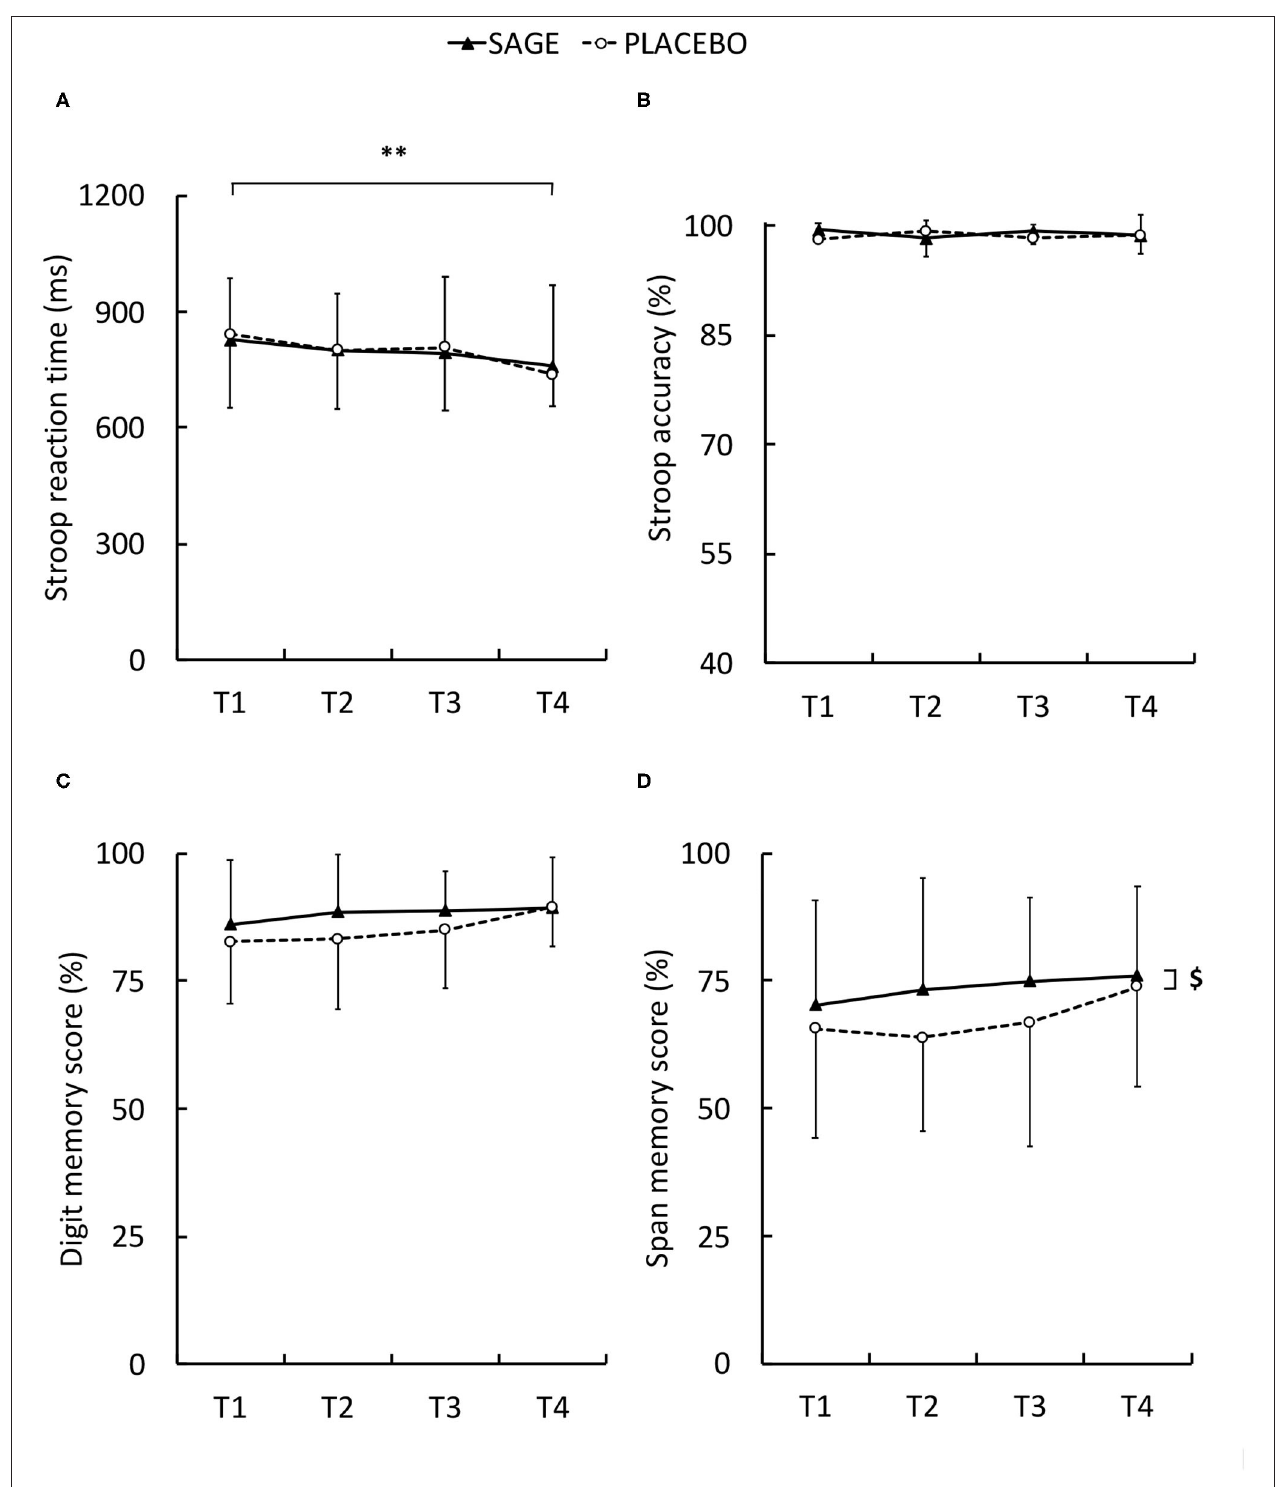
FIGURE 5 | Stroop reaction time (A) , Stroop accuracy (B) , digit memory score (C) , and span memory score (D) with SAGE and PLACEBO supplementations during the different tests. T1, T2, T3, and T4 were tests following warm-up, first and second fatiguing stages, and recovery, respectively. ** significant difference between tests whatever the supplementation ( P < 0.01). $ main significant effect between the supplementation ( P < 0.05).